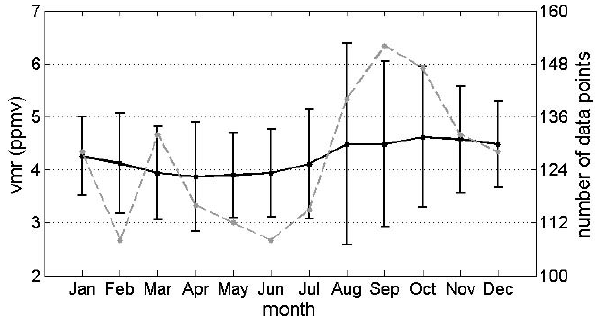
Fig. 4. Mean monthly water vapor mixing ratios (ppmv) measured by MLS over the altitude range of ∼ 17–19.5km. The average was computed using MLS v3.3 data from August, 2004 until February, 2011. The scale for the mixing ratio (solid black line) is on the left while the scale for the number of measurements used in each average (dashed grey line) is shown on the right. The error bars plotted are 2- σ